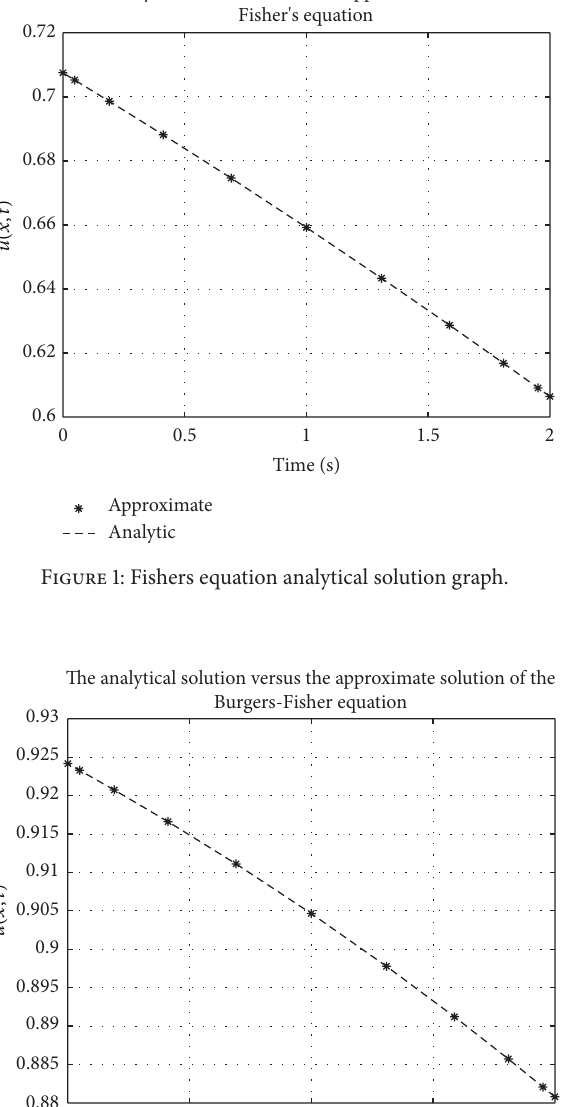
numerical schemes such as finite